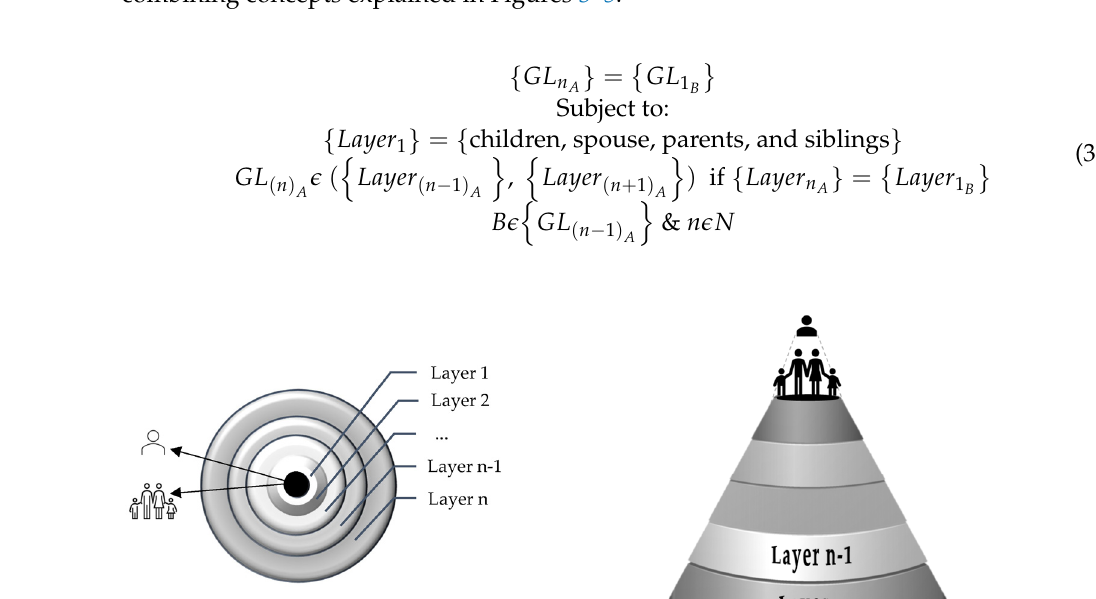
Equation (3) will result from incorporating the grey-layer concept into the multi-layer family. With a 3D perspective, Figure 6 presents the multi-layer family model in a clone, combining concepts explained in Figures 3–5.